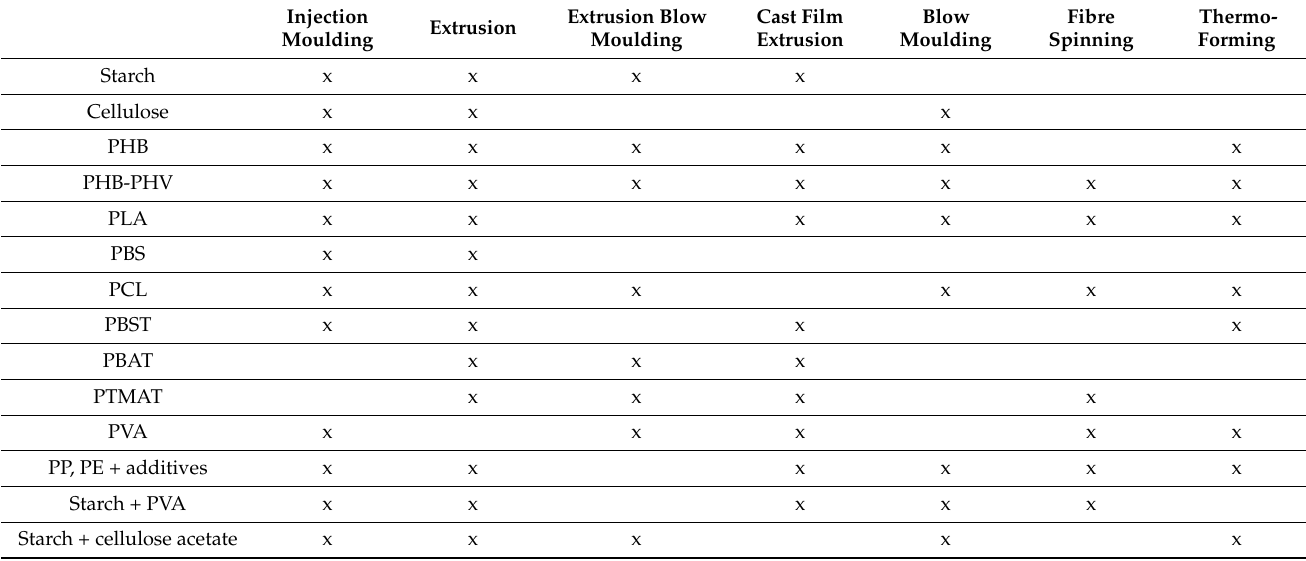
Table 3. Processing possibilities of typical commercial biopolymers. Adapted from “Poly-Lactic Acid: Production, applications, nanocomposites, and release studies”, Comprehensive Reviews in Food Science and Food Safety, vol. 9, no. 5, pp. 552–571, September 2010 [2]. Extrusion Blow Cast Film Blow Fibre Injection Extrusion Moulding Extrusion Moulding Moulding